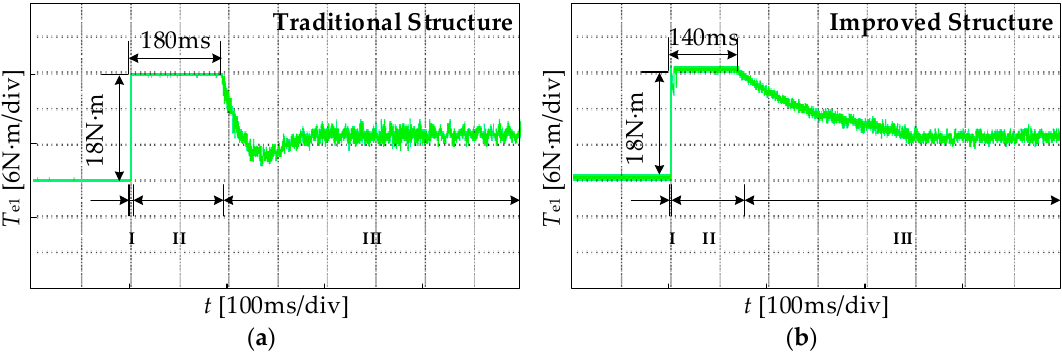
Figure 15. Electromagnetic torque output of the first motor during the start-up of motors with load: ( a ) Electromagnetic torque output in the traditional structure; ( b ) Electromagnetic torque output in the improved structure.